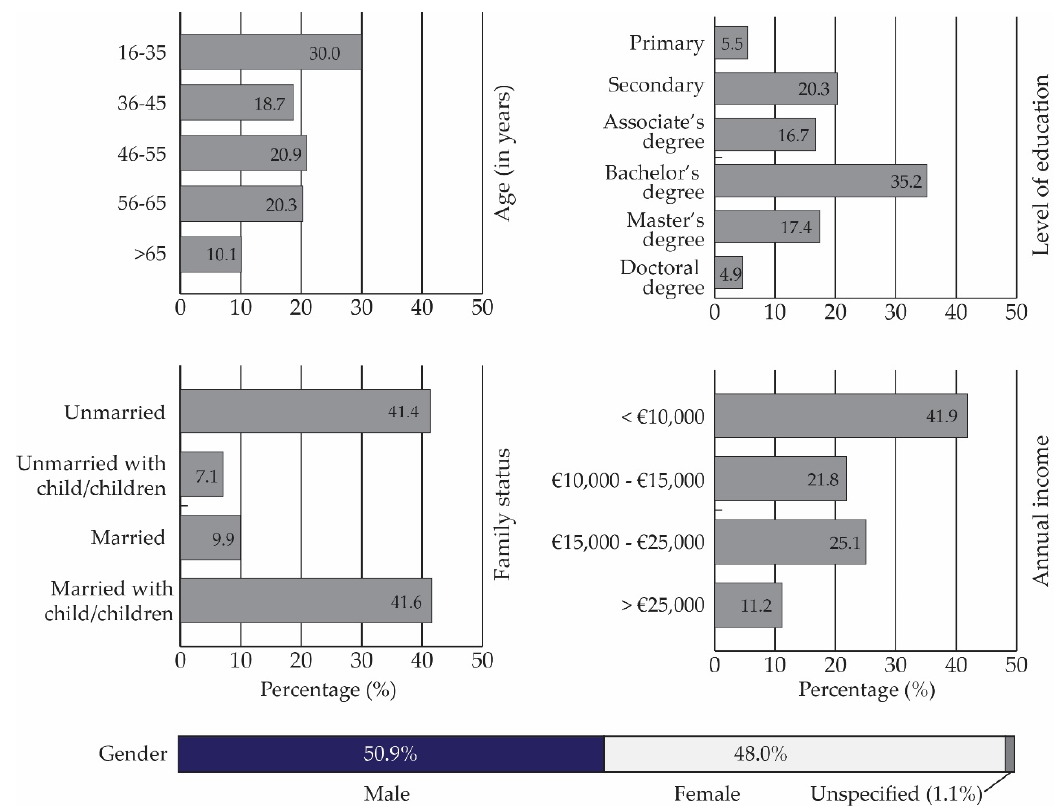
Figure 1. Respondents’ demographics.